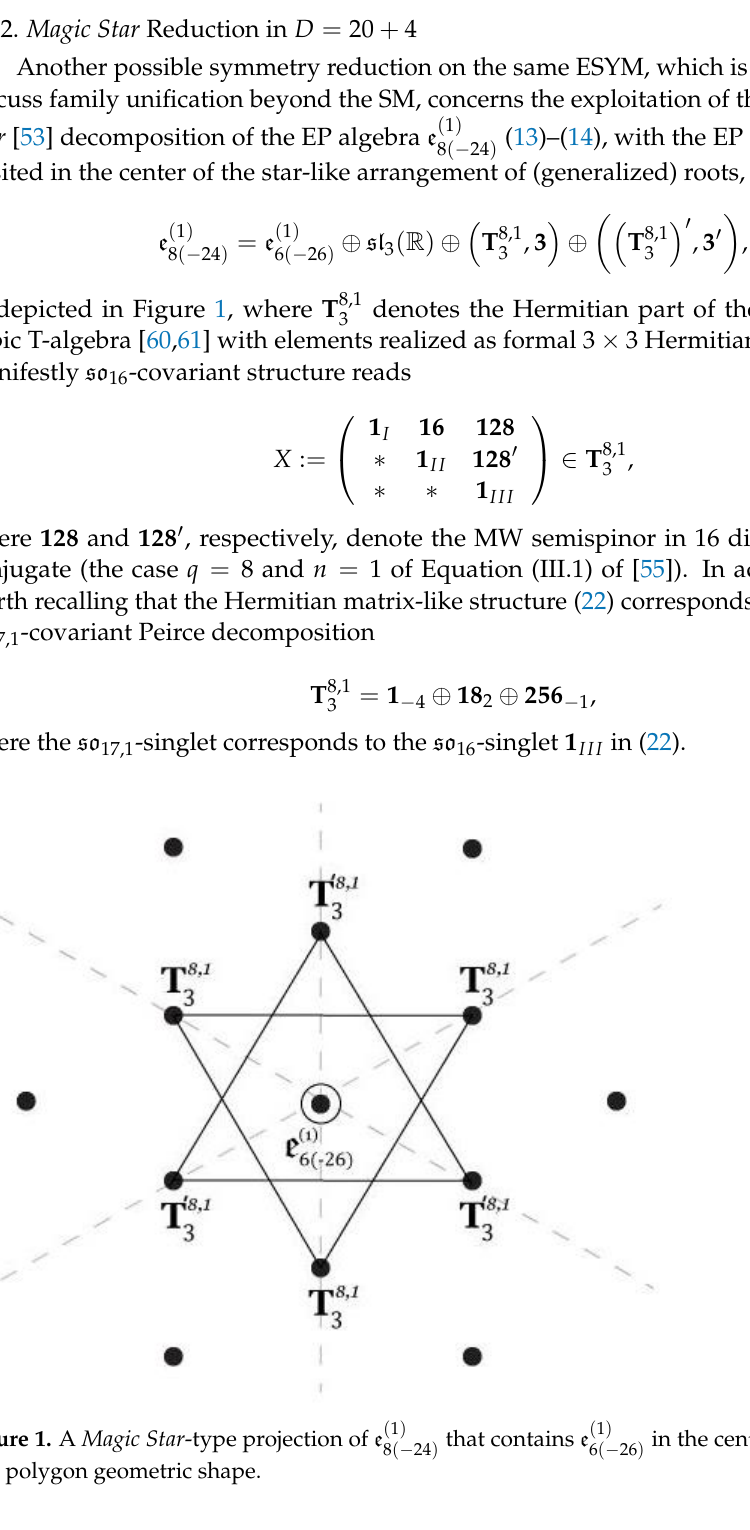
Figure 1. A Magic Star -type projection of e star polygon geometric